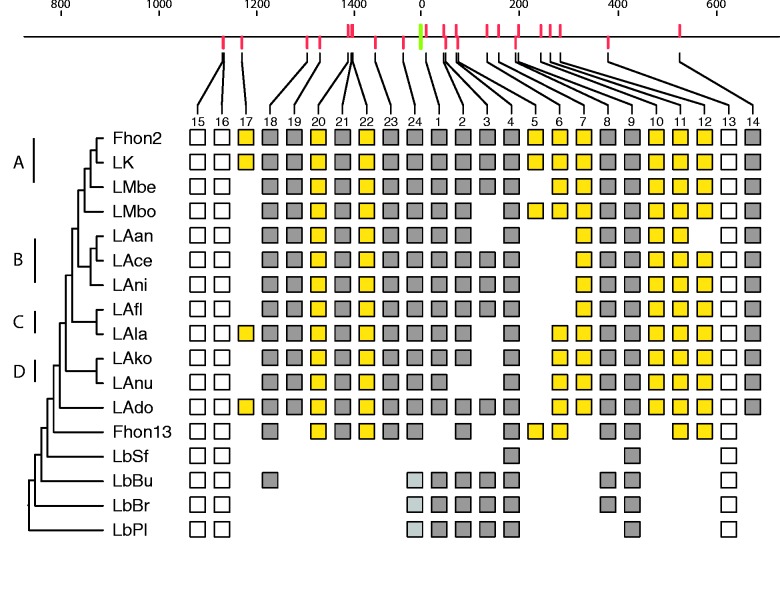
Overview of the location and presence profile of genes coding for secreted proteins. The upper line represents the segment of the Fhon2 genome surrounding the origin of replication (green bar) and the location of the genes coding for secreted proteins (red bars). Tick marks represent the distance in kb. For each gene, its presence/absence profile is shown. Yellow boxes represent genes for secreted proteins that are present in L. kunkeei but in no other lactobacilli for which complete genome data are present, gray boxes represent genes with orthologs in other lactobacilli and white boxes represent genes putatively falsely predicted to be secreted. The tree topology and the microclusters (letters A–D) are as in figure 1b.